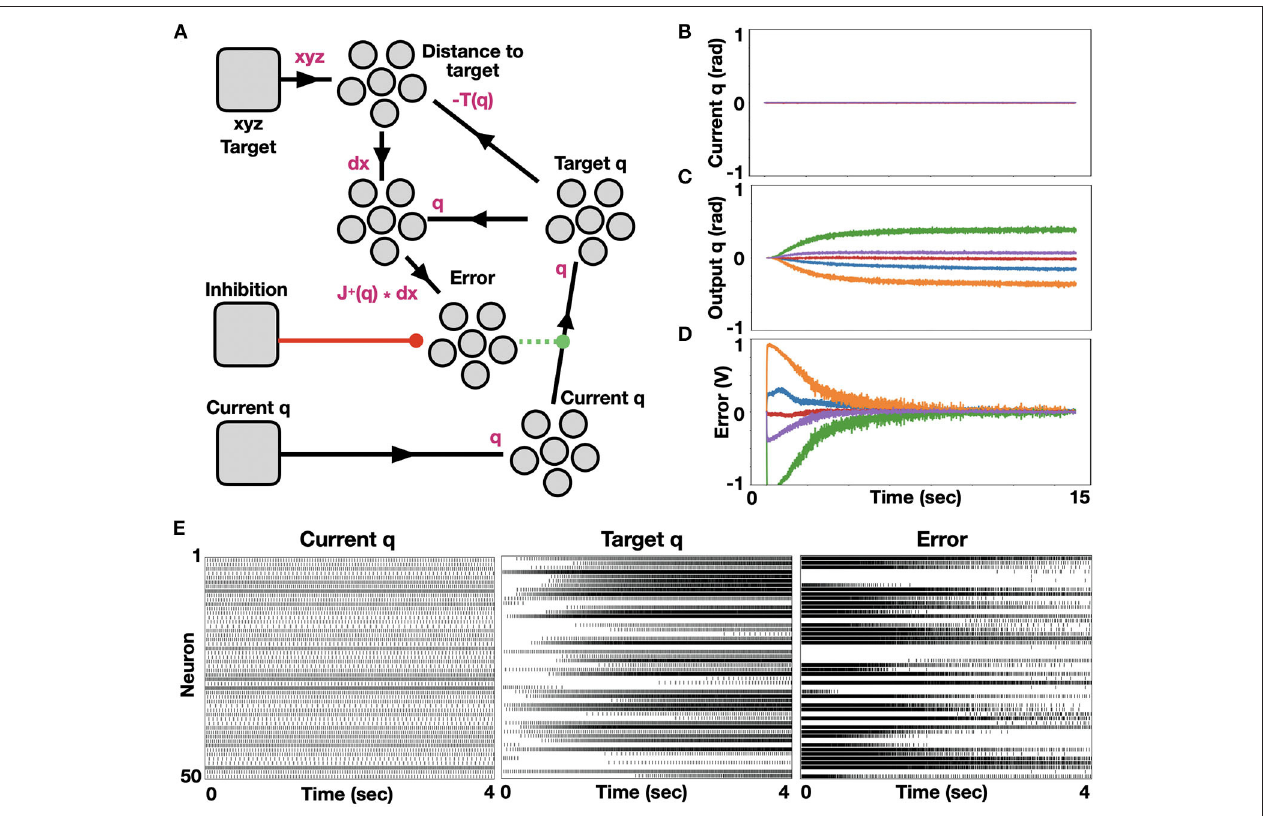
FIGURE 1 | Neuromorphic implementation of IK. (A) A model for neuromorphic IK with online learning. Initial joint configuration is represented with neural ensemble Current q and transformed to a target joint configuration, represented with neural ensemble Target q . This transformation is modulated (or learned) by minimizing an error term, represented with neural ensemble Error , defined by distance to target. Nodes, which were used here to introduce signals are shown as rounded squares and ensembles, which represent groups of spiking neurons are represented with a group of 5 circles; (B) Initialized zeroed states of the five joints angle; (C) Monitored target joint angles as the algorithm optimized arm reaching to point [0.246, 0.62, 0.373] in task space. Each color represents a different joint angle, where bottom to top curves (orange to green) correspond to the base to top joints of the robotic arm; (D) Monitored error, demonstrating error flattening as the arm is reaching its target (learning rate is 0.001); (E) Raster plots of ensembles Current_q , Target q and Error